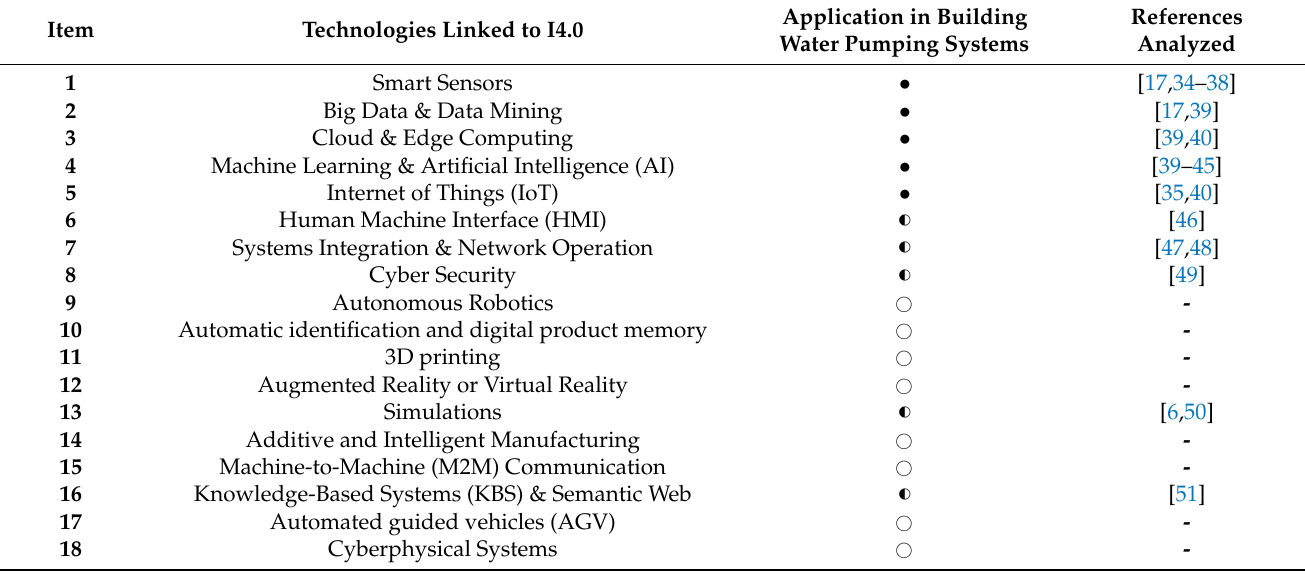
Table 2. Overview of I4.0 pillar concepts found in literature review papers.